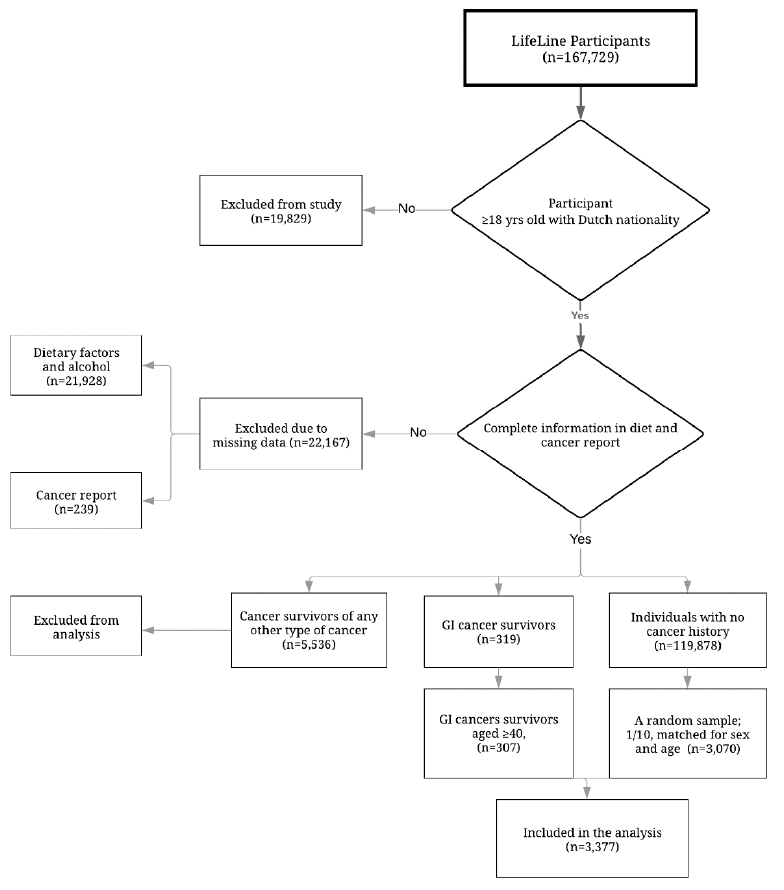
Figure 1. Study flow chart. Table 1. Di ff erences in mean Lifelines Diet (LLD) score according to demographics and health-related characteristics of the study population stratified by cancer status; Lifelines (2006–2009) 1